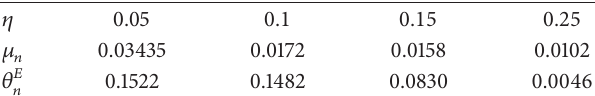
Table 2: Einstein rings and magnifications ( 𝑛 = 2 ) for ordinary global monopole.